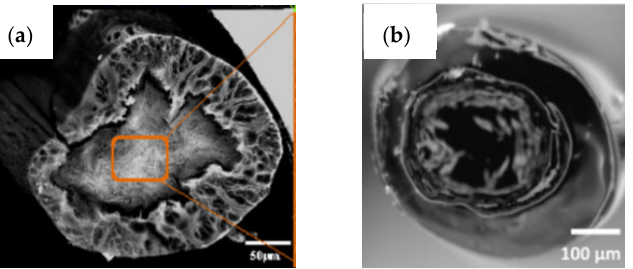
Figure 8. SEM micrographs of ( a ) core-shell and ( b ) tri-axial wet-spun fibers (adapted with permission from [145], published by Wiley, 2015 and adapted from [146], published by MDPI, 2020).